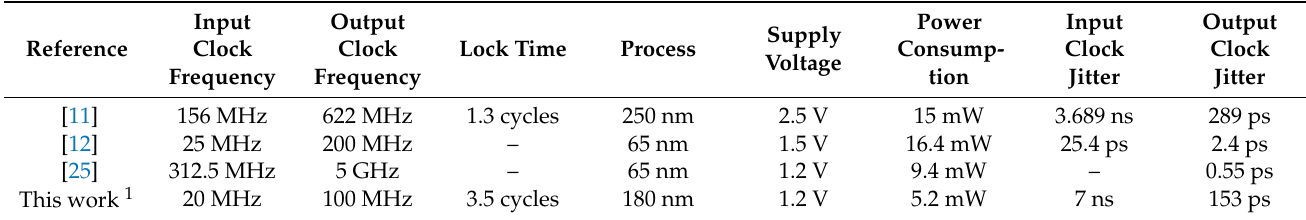
Table 4. Performance comparison of phase interpolation clock multipliers